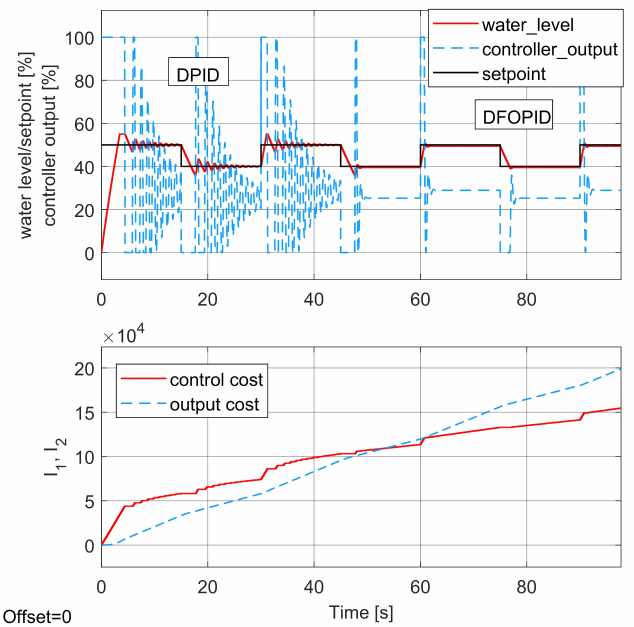
Figure 8. Comparison of the fractional-order PID controller (DFOPID) and DPID control system implementations on the Simulink